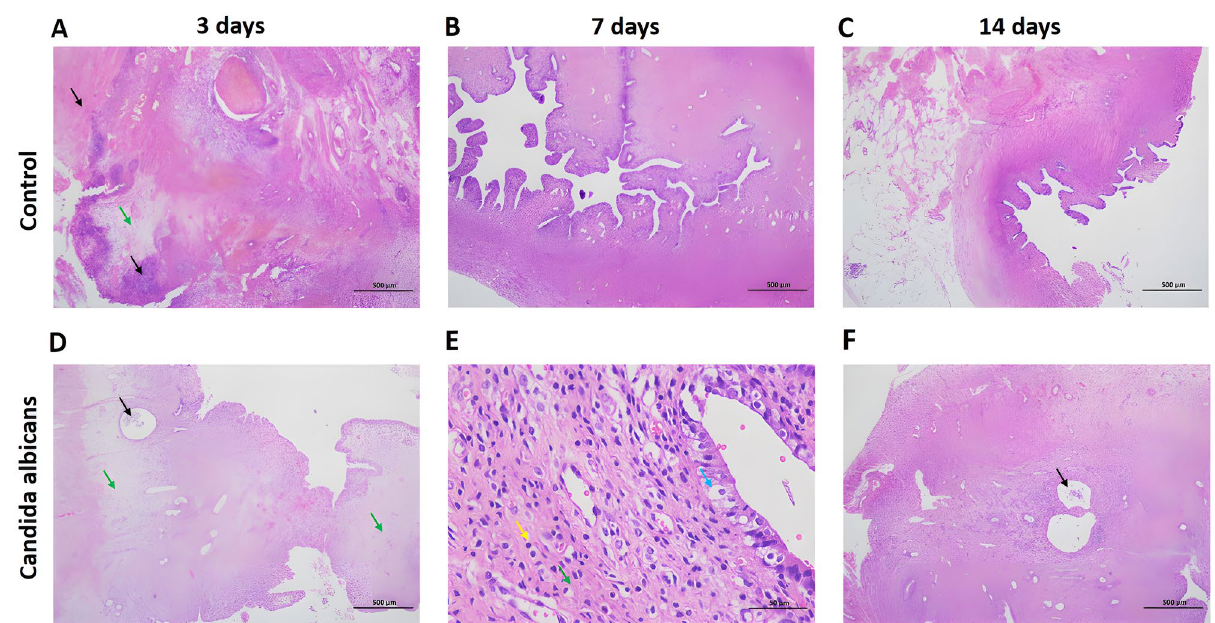
Figure 2. H&E staining of rat endometrial tissues on postoperative days 3, 7, and 14 in the Candida albicans and control groups. ( A ) On day 3, H&E staining results in the control group show suppurative necrosis (black arrows) and local edema (green arrow). ( B,C ) H&E staining results in the control group on the day 7 and 14. ( D ) On day 3, H&E staining results in the C. albicans group show neutrophils (black arrow) and lamina propria edema (green arrows). ( E ) On day 7, H&E staining results in the C. albicans group show local uterine epithelial cytoplasmic vacuolation (blue arrow), a small number of lymphocytes (yellow arrow), and more collagen fiber hyperplasia (green arrow) in the lamina propria. ( F ) On day 14, H&E staining results in the C. albicans group show inflammatory exfoliation and deletion of the uterine epithelium (black arrow). H&E hematoxylin and